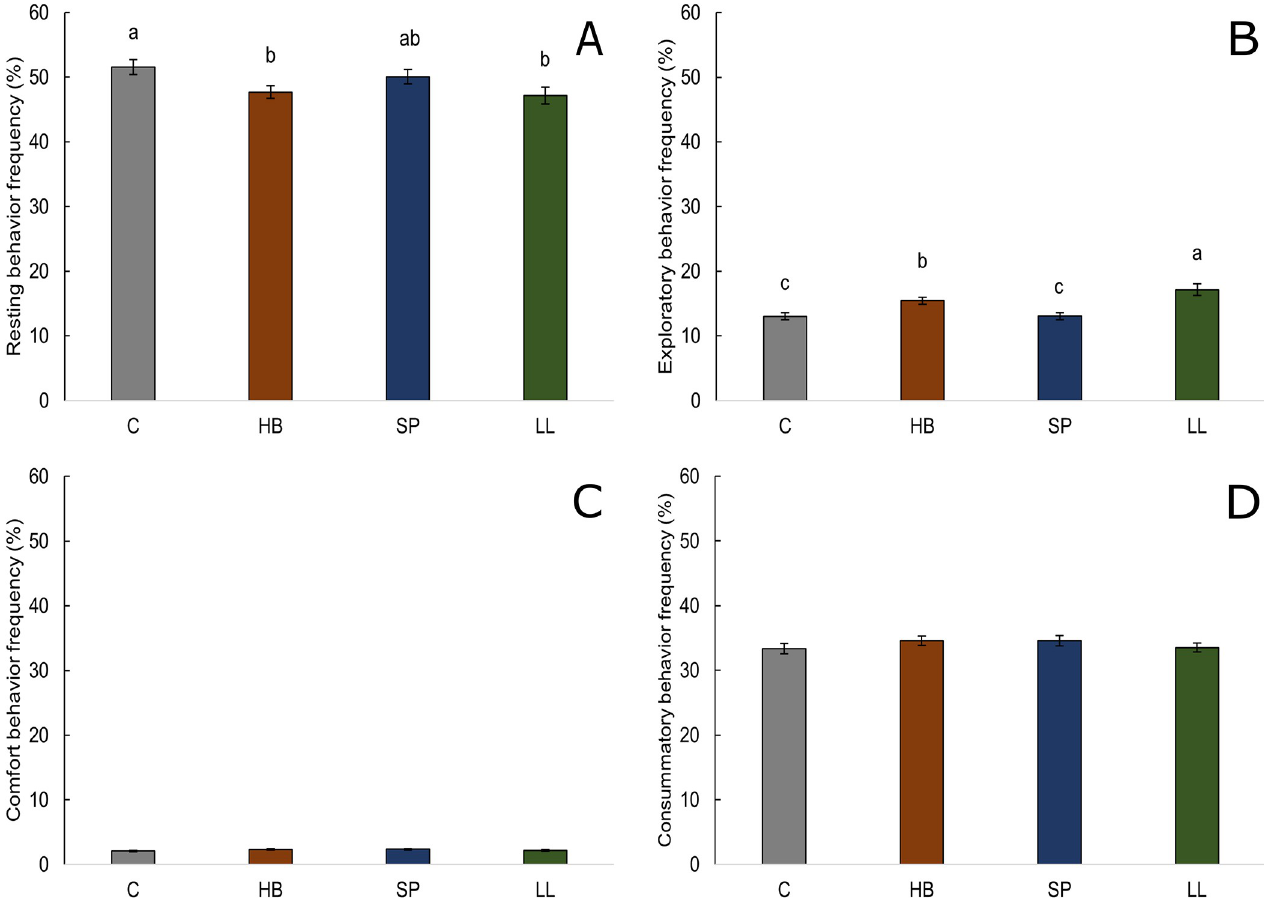
Fig 3. Frequency of observations (mean % ± SEM) of each behavioral category by treatment (C = control, HB = hay bales, SP = step platforms, LL = laser lights) across 2 time periods (09:00 and 15:00 h), n = 192 observations. Frequencies of (A) resting behavior, (B) exploratory behavior, (C) comfort behavior, and (D) consummatory behavior. Means within behavioral category without a common superscript ( a–c ) differed at P < 0.05.